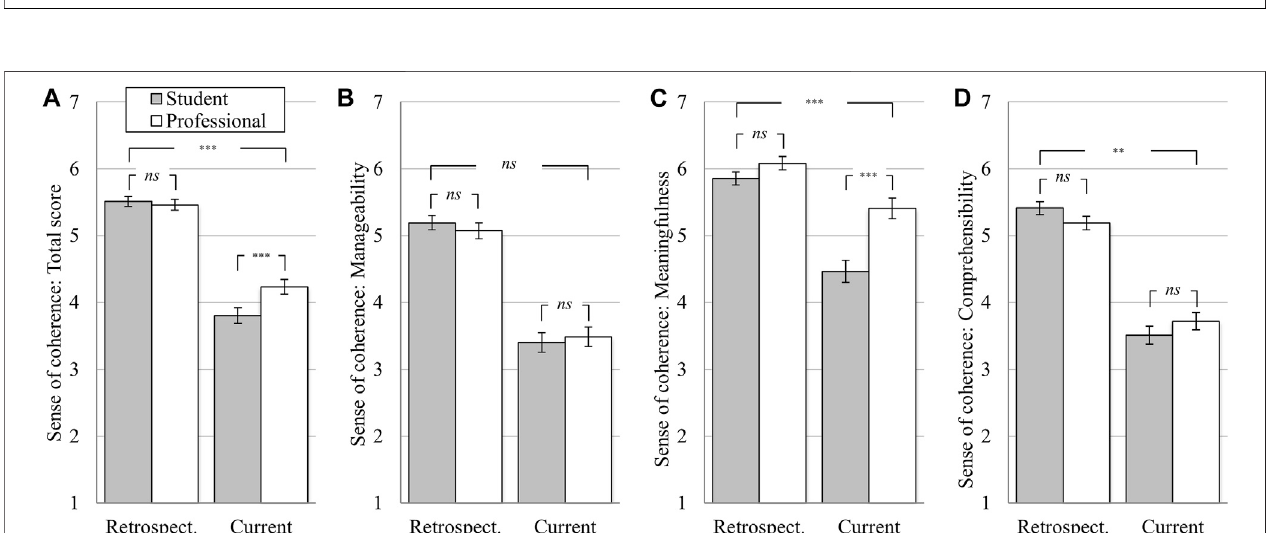
FIGURE 3 | Change in sense of coherence differentiated between students and professionals; (A) : total score, (B) : manageability, (C) : meaningfulness, (D) : comprehensibility. Notes : between groups (students vs professionals) and interaction effects; * p < 0.05; ** p < 0.01; *** p < 0.001; means with 95% con fi dence intervals (7-point semantic differentials; see Table 1 for item anchors); retrospective (cid:1) retrospective rating related to a pre-pandemic time-point; current (cid:1) rating of the current time-point (February/March 2021); students ( n (cid:1) 324) vs professionals ( n (cid:1) 324); N (cid:1) 648.